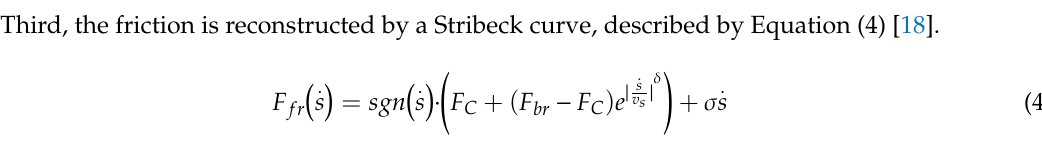
Figure 2. Stribeck curve: ( a ) fitted for the X -axis of the HSC30; ( b ) fitted for the Y -axis of the HSC30. Third, the friction is reconstructed by a Stribeck curve, described by Equation (4) [18].